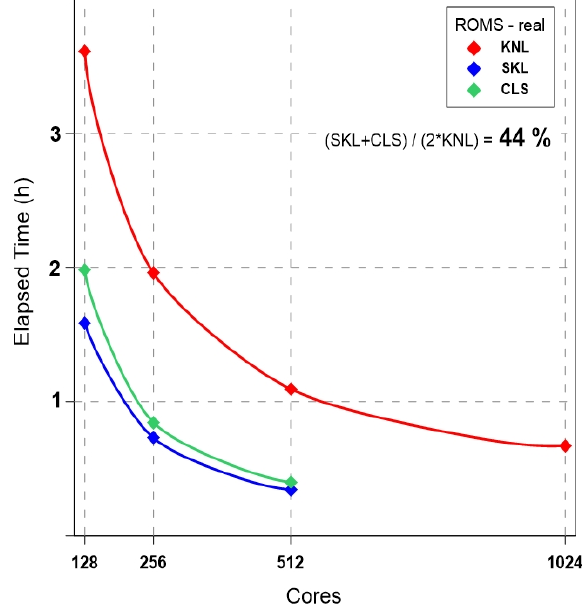
Figure 14. Performances of ROMS-NWP with respect to the number of cores for the real experiment: (SKL + CLS) / (2*KNL) = 44%.